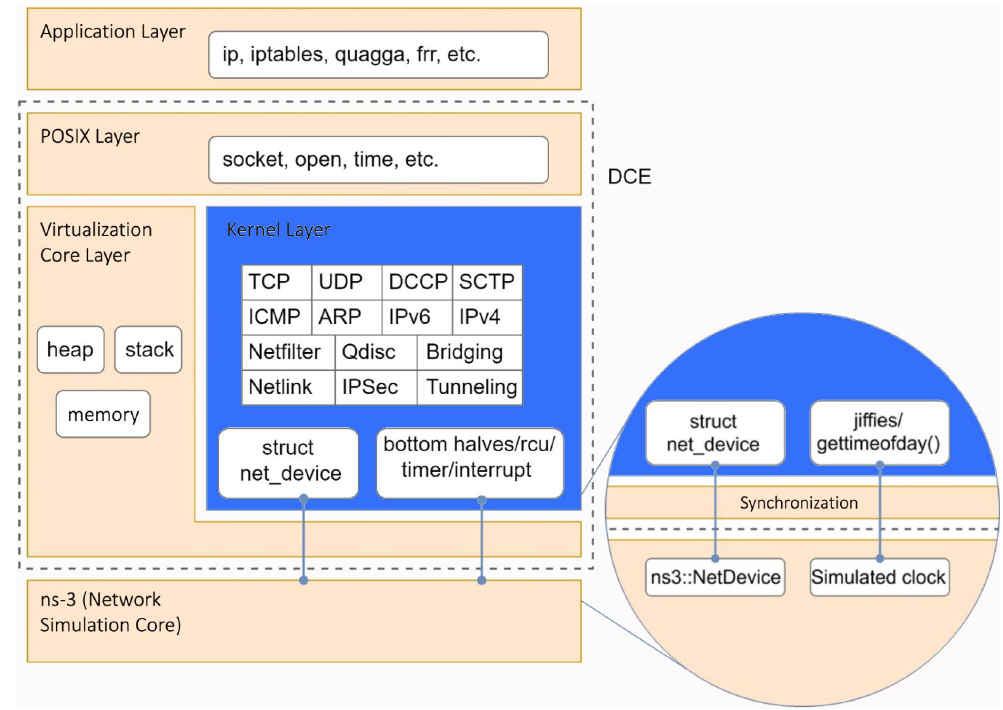
Figure 3. Architecture of DCE. The application layer is where our programs will be executed using DCE to connect to the core of the network simulator (ns-3). [Prepared by the authors on the basis of an image obtained from